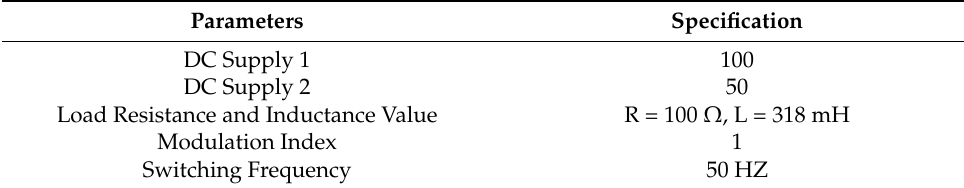
Table 4. Parameters used for simulation.